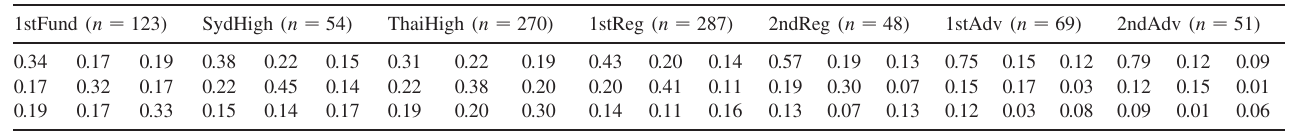
TABLE IV. Class model density matrices for questions 2–5 on wave speed.